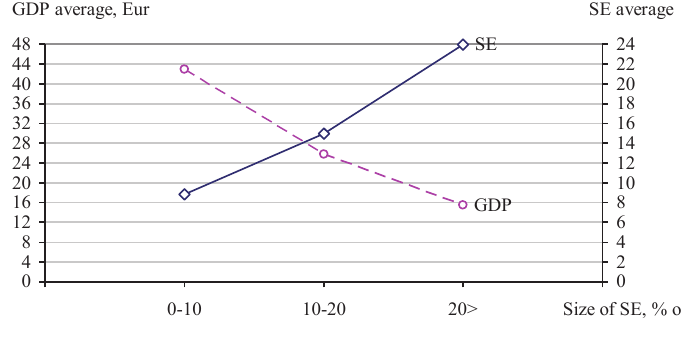
Fig. 4 – Nature of the impact of national economic development on the size of the shadow economy in the EU. Source: own